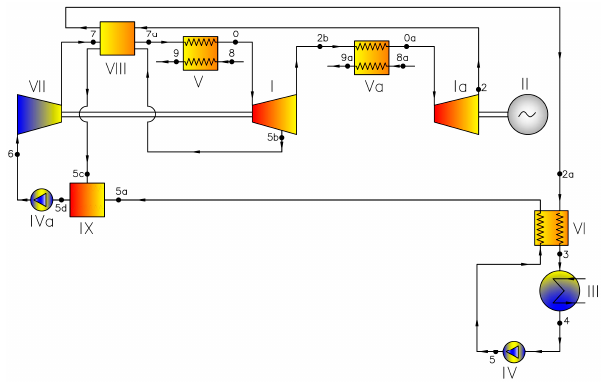
Figure 5. ORC cycle with regenerator, compressor, reheater and interstage superheater; where: Ia, Ib—turbines, II—generator, III—condenser, IV-pump, V—vapor generators, Va—interstage superheater, VI—regenerator, VII—compressor, VIII—heat exchanger (Variant 7). Energies 2020 , 13 , x FOR PEER REVIEW